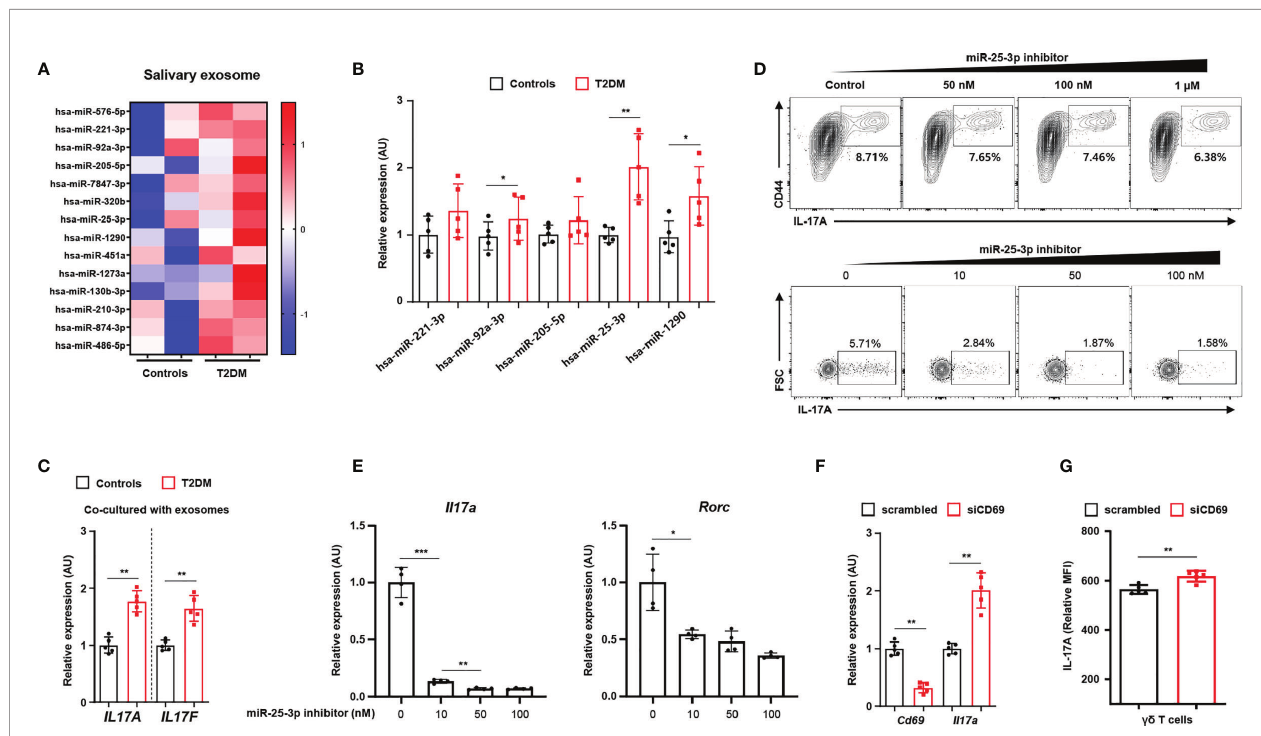
FIGURE 2 | Salivary exosomal miRNA pro fi les in healthy individuals and in patients with type 2 diabetes. (A) Heatmap showing differentially enriched miRNAs in salivary exosomes from patients with type 2 diabetes as compared with those from normoglycemic healthy individuals. (B) Expression of differentially enriched miRNAs in salivary exosomes was measured by real-time PCR. (C) Co-culturing gd T cells with salivary exosomes (from either healthy individuals or patients with type 2 diabetes) with anti-CD3 (2 m g/mL), anti-IL-2 (10 ng/mL), and isopentenyl pyrophosphate (5 m g/mL). (D) The population of IL ‐ 17A-producing cells under culture conditions of gd T cell activation at the indicated concentrations of miR-25-3p inhibitors. (E) Transcription of Il17a and Rorc in differentiated CD4 + T cells under T H 17 differentiation-inducing culture conditions at the indicated concentrations of miR-25-3p inhibitors. (F, G) gd T cells were transfected with either control siRNA or anti- CD69 siRNA for 48hr. Expression levels of IL-17A were measured by using qPCR and FACS analysis. Data represent mean values of more than three independent experiments. Data are expressed as the mean ± SEM. *p < 0.05, **p < 0.01, ***p < 0.001 (B, C, F, G) , two ‐ tailed t tests; (E) , one ‐ way